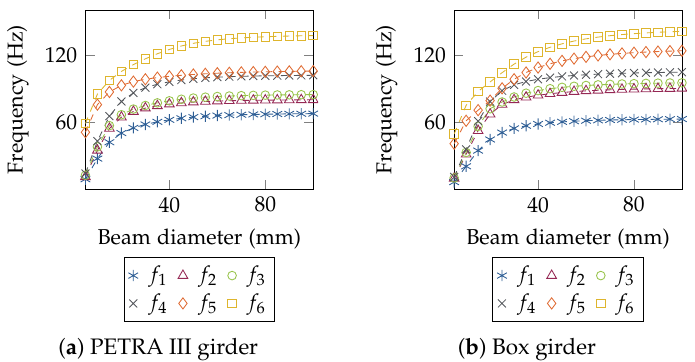
Figure 23. First six eigenfrequencies of the magnet–girder assembly depending on the cross section diameter of the three beams connecting the PETRA III girder ( a ) and the box girder ( b ) to the three